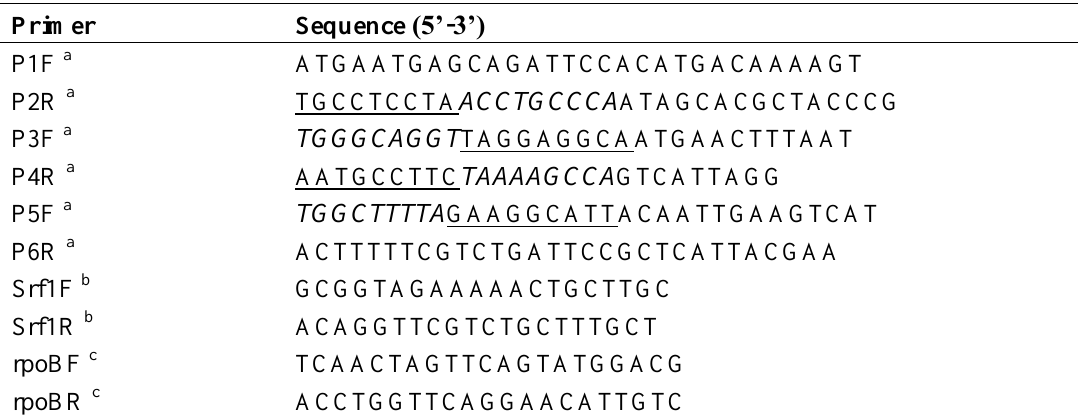
Table 4. Primers used in this